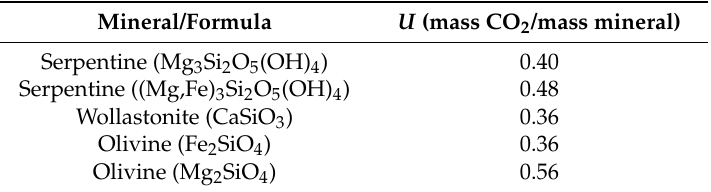
Table 2. Carbonation potential for different naturally occurring minerals